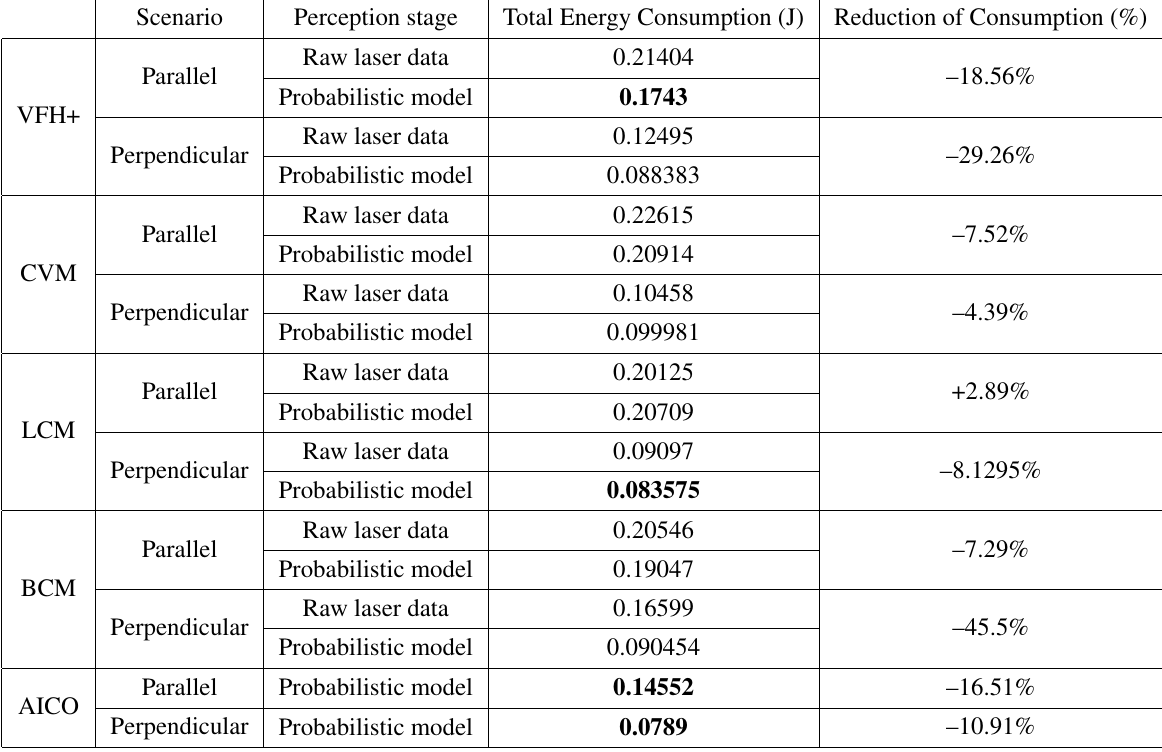
Table 1. Summary of results for energy consumption. AICO is being compared with the best reactive method for the given